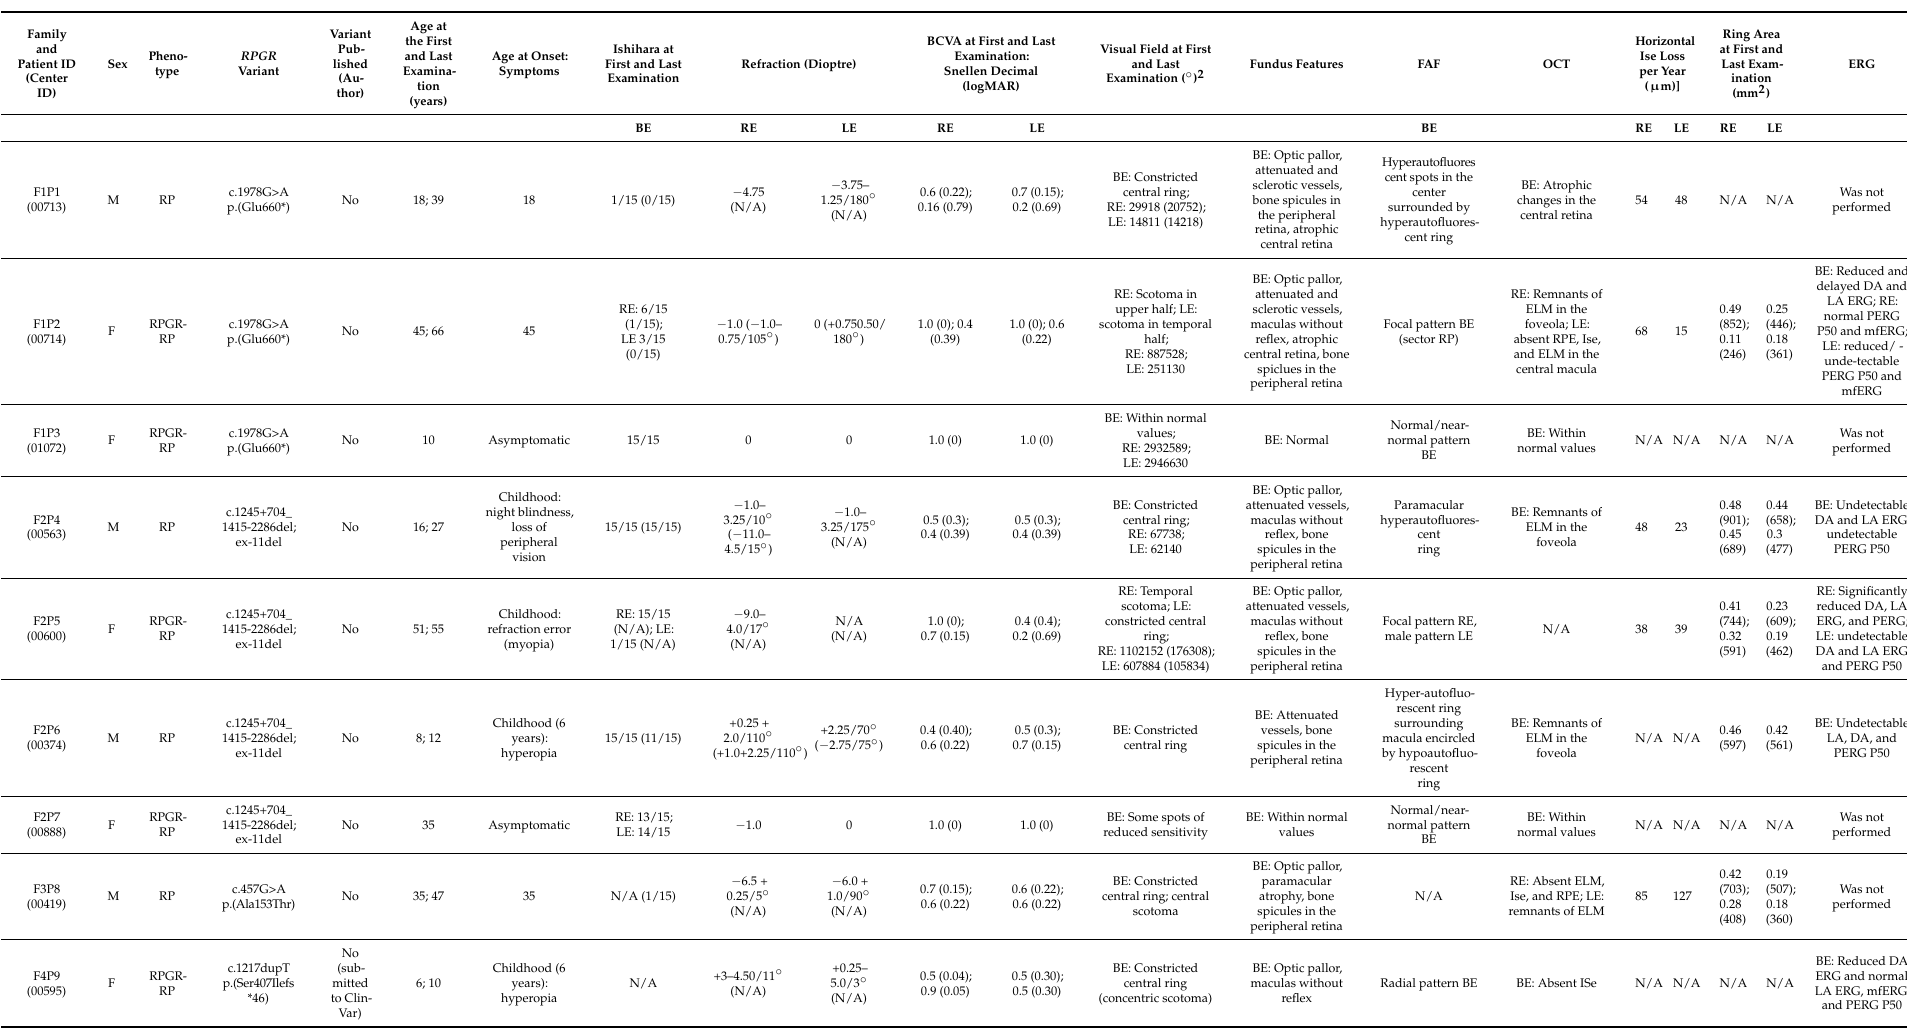
Table 1. Patients’ Clinical